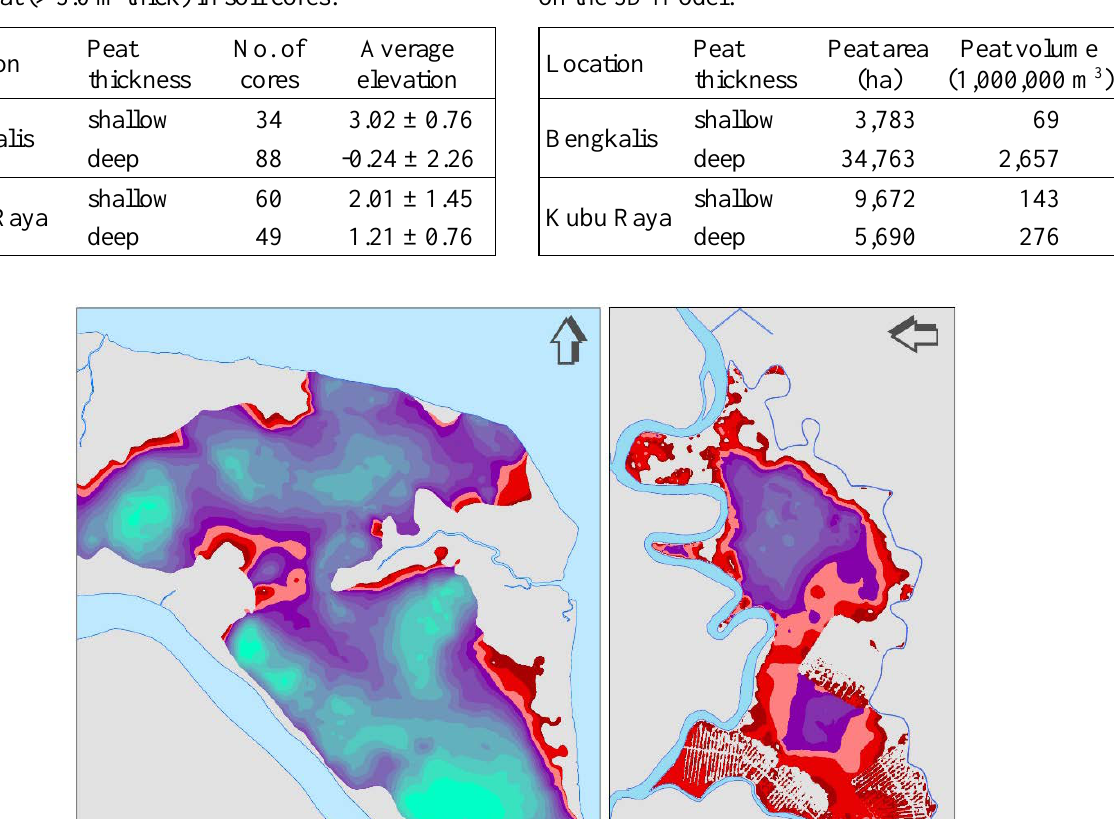
Table 2. Peat extent and volume for shallow peat